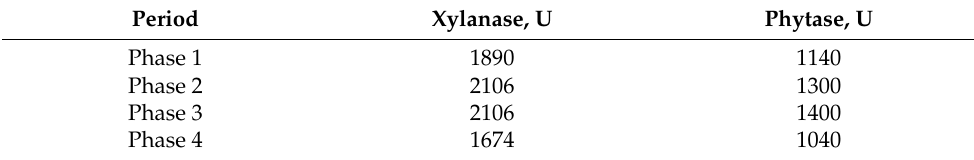
Table 2. The analyzed activities of xylanase and phytase in NC + MCPC diet.